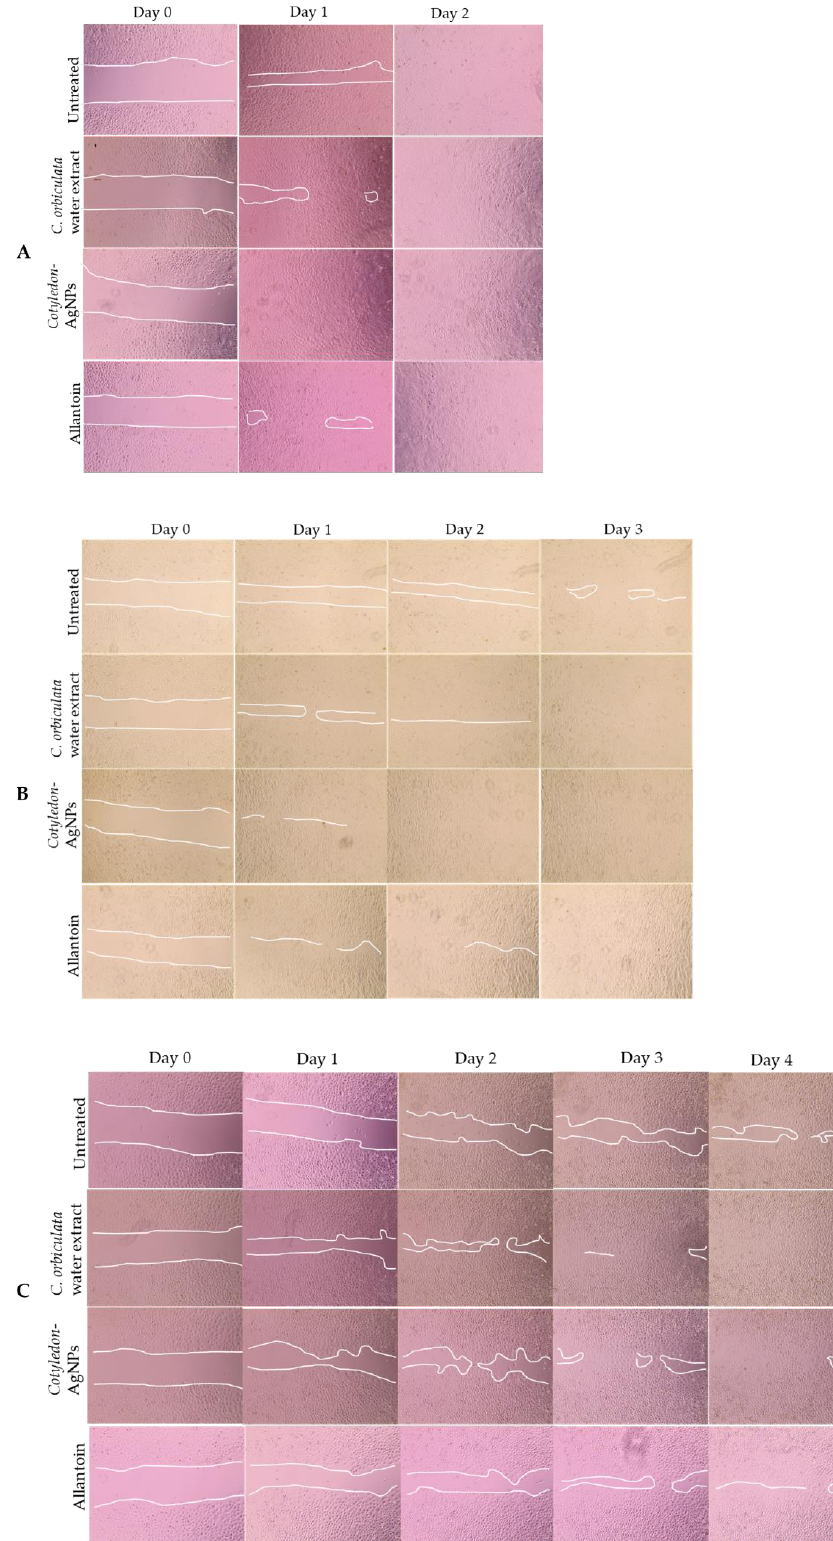
Figure 2. Scratch assay analysis of Cotyledon -AgNPs (2.5 µ g/mL) and C. orbiculata water extract (15 µ g/mL) on HaCaT ( A ), CHO ( B ) and KMST-6 ( C ) cells. The white lines in the images are boundaries of the scratched